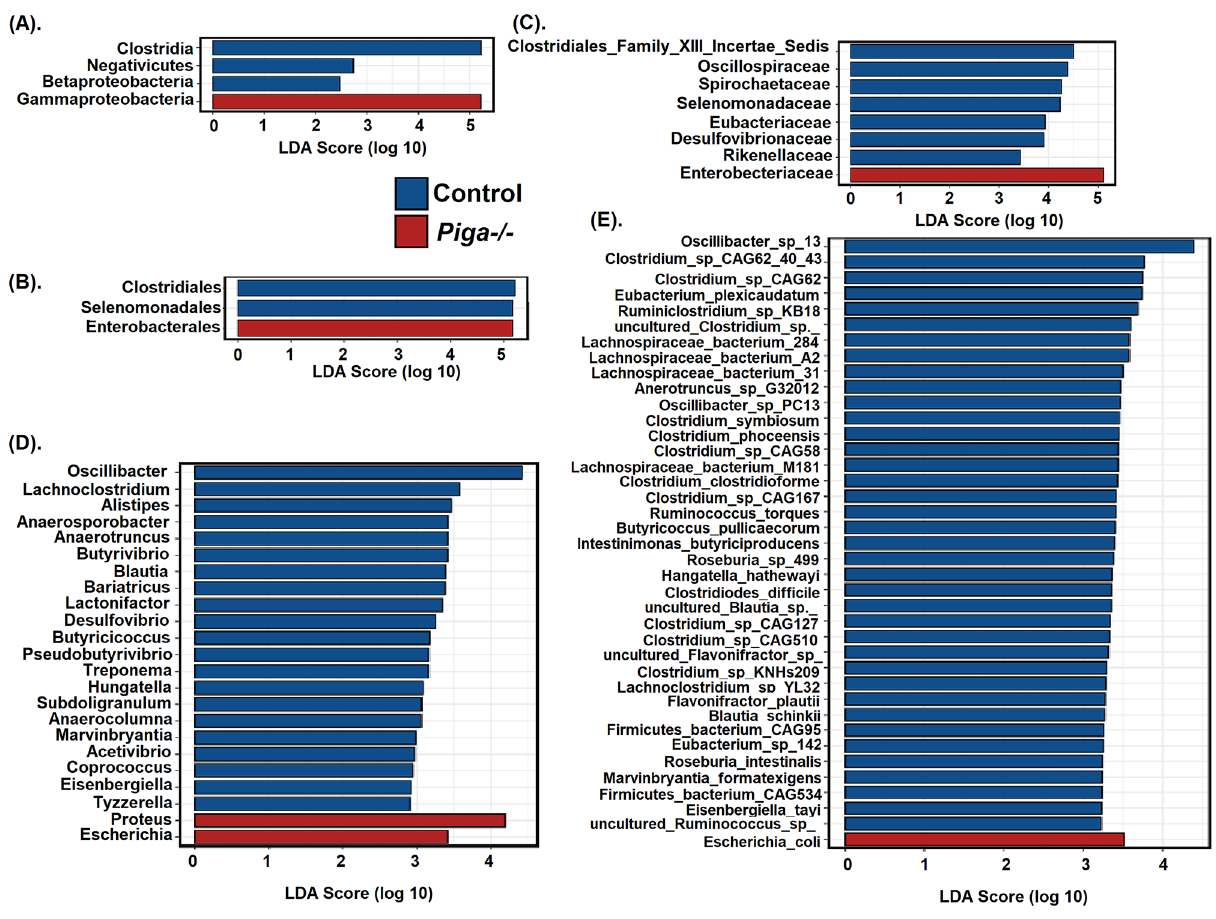
Figure 3. Differentiating biomarkers identified using the LEfSe analysis on different levels of taxonomy, namely, ( A ) class, ( B ) order, ( C ) family, ( D ) genus, and ( E )